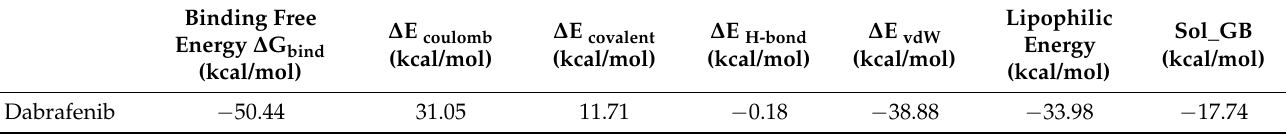
Table 7. MM-GBSA binding energies of Dabrafenib docked at active site of